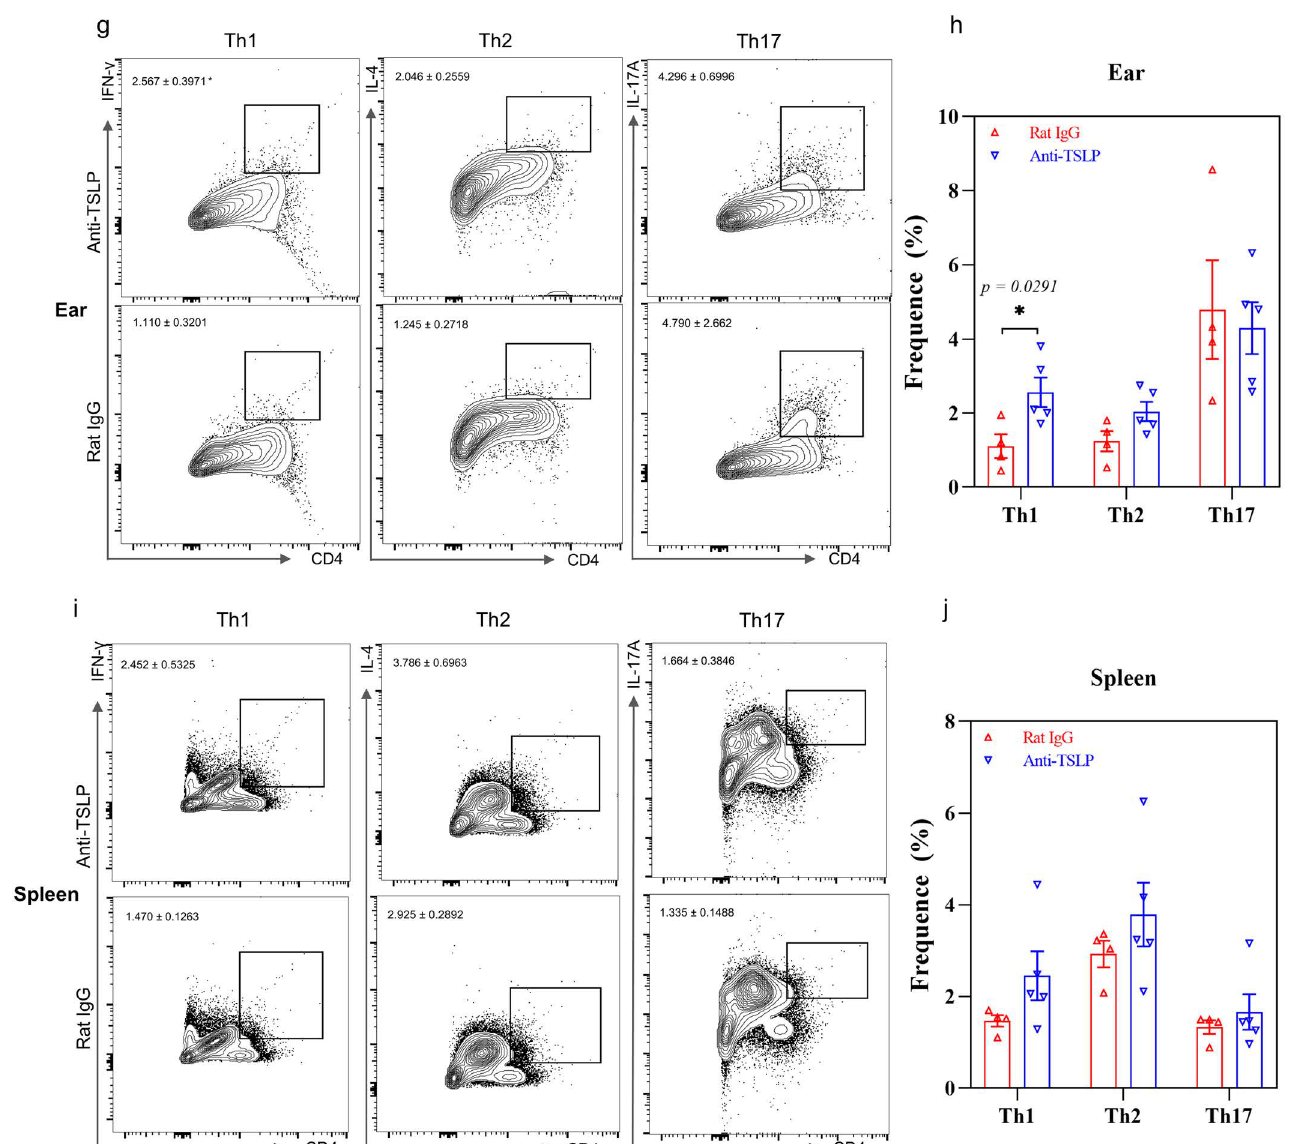
Figure 4. Effects of the anti-TSLP treatment on AD. ( a ) AD murine model schedule; ( b ) ear swelling, skin moisture and scratching times; ( c ) flow cytometric analysis of basophil, eosinophil and mast cell population in the ear tissue; ( d ) quantitative analysis of result in ( c ); ( e ) flow cytometry analysis of basophil, eosinophil and mast cell population in the spleen; ( f ) quantitative analysis of result in ( e ); ( g ) flow cytometry analysis of Th1, Th2 and Th17 cell population in ear tissue; ( h ) quantitative analysis of result in ( g ); ( i ) flow cytometry analysis of Th1, Th2 and Th17 cell population in the spleen; ( j ) quantitative analysis of result in ( i ). Bar charts are shown as mean ± SEM of n = 4 or 5. * p < 0.05 and ** p < 0.01 when compared between the